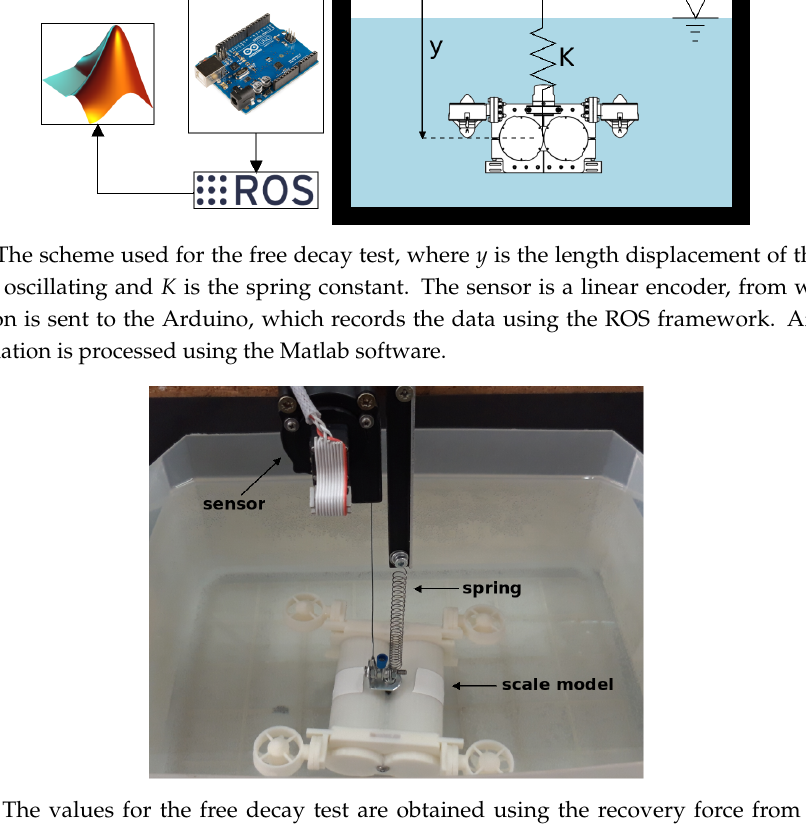
Figure 6. The values for the free decay test are obtained using the recovery force from a spring. The parameters required for obtaining the values used in this case are shown in Table 2.